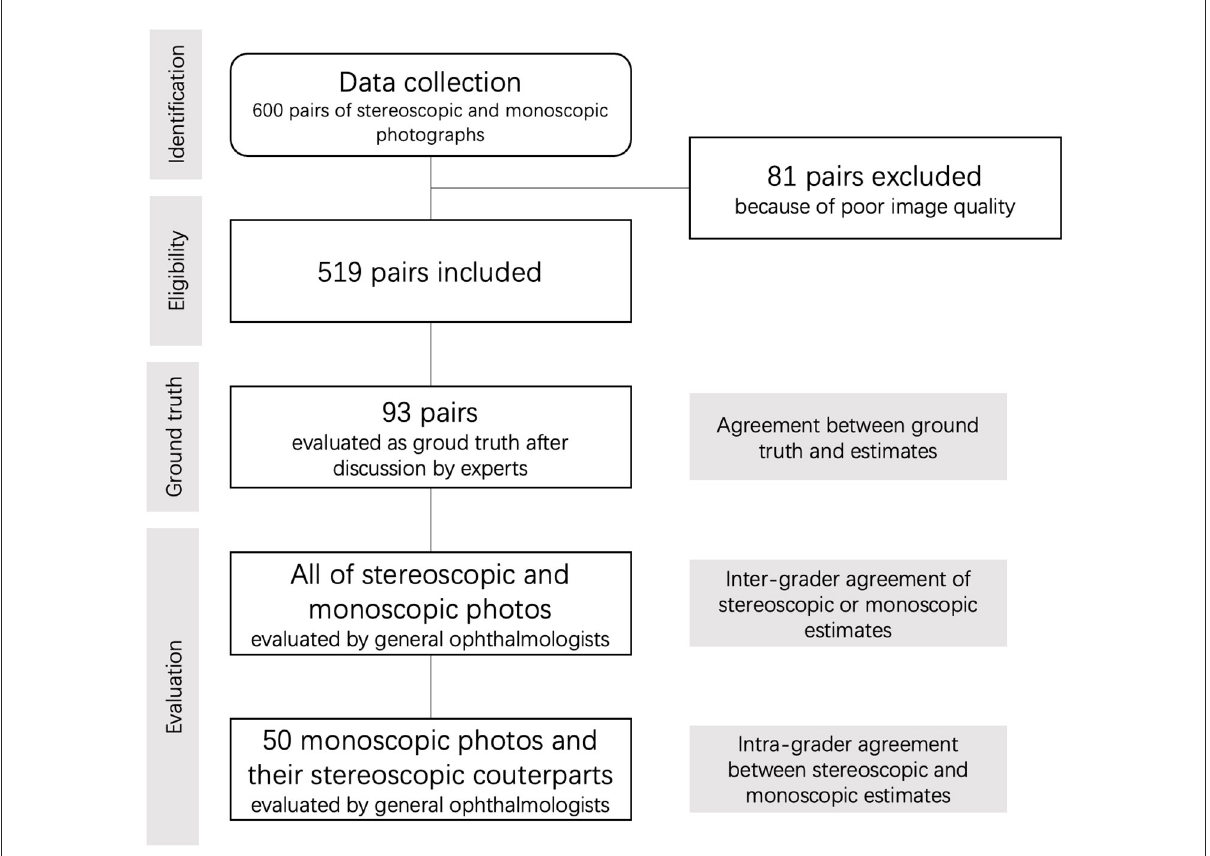
FIGURE1 Flow chart of the current study.